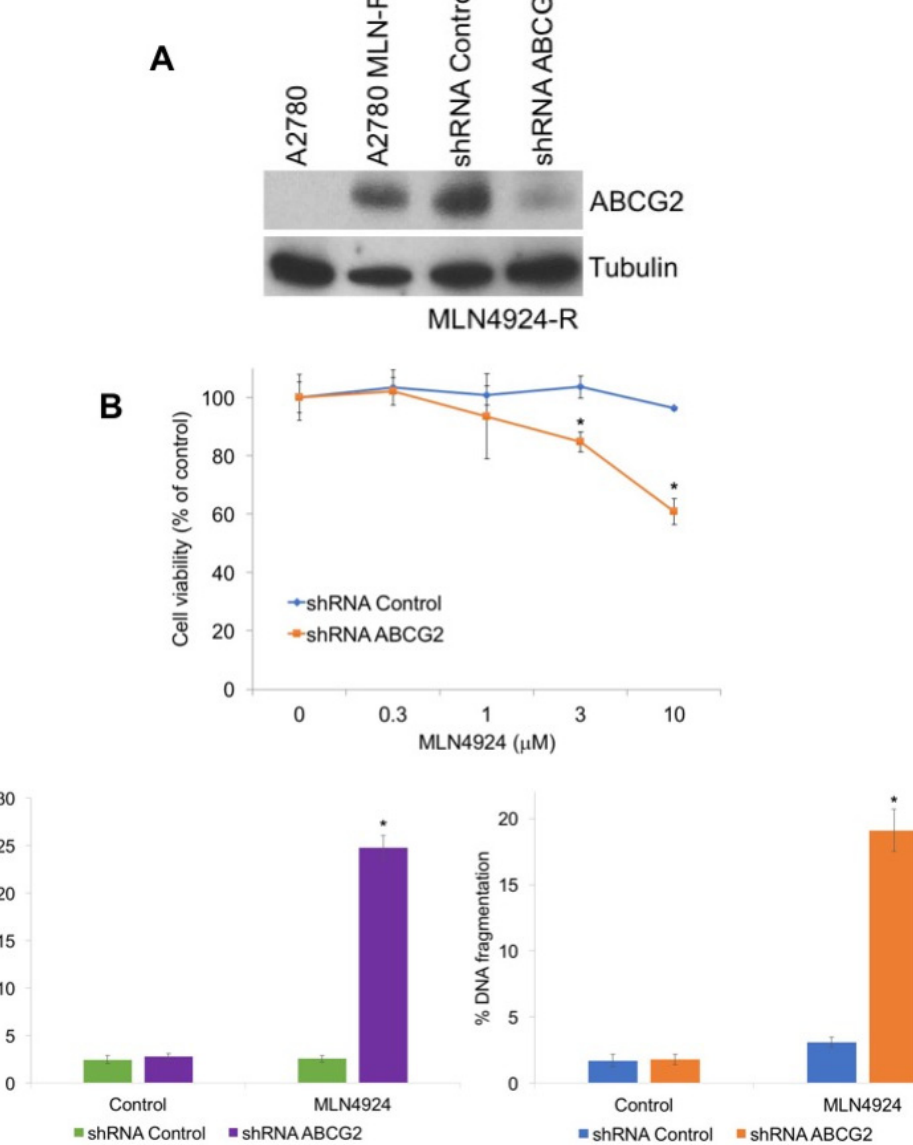
Figure 3. Knockdown of ABCG2 re-sensitizes resistant cells to MLN4924 treatment. ( A ) Knockdown of ABCG2 in MLN4924-resistant cells. A2780 / MLN-R cells were infected with non-target control or ABCG2 lentiviral shRNA and positively infected cells were selected with puromycin. Immunoblotting confirmed knockdown of ABCG2 in the resistant cells. ( B ) Knockdown of ABCG2 re-sensitizes resistant cells to MLN4924. A2780 / MLN-R cells were infected with control or ABCG2 lentiviral shRNA and were treated with the indicated concentrations of MLN4924 for 72 h. Cell viability was determined by MTT assay. Mean ± SD, n = 3. * Indicates a significant di ff erence compared to non-target control-transfected cells treated with the same concentration. p < 0.05. ( C ) Diminished ABCG2 expression sensitizes resistant cells to MLN4924-mediated apoptosis. A2780 / MLN-R cells infected with control or ABCG2 lentiviral shRNA were treated with 10 µ M MLN4924 for 48 h. Apoptosis was determined by measuring active caspase-3 by flow cytometry and PI-FACS analysis. Mean ± SD, n = 3. * Indicates a significant di ff erence from shRNA control MLN4924-treated cells.